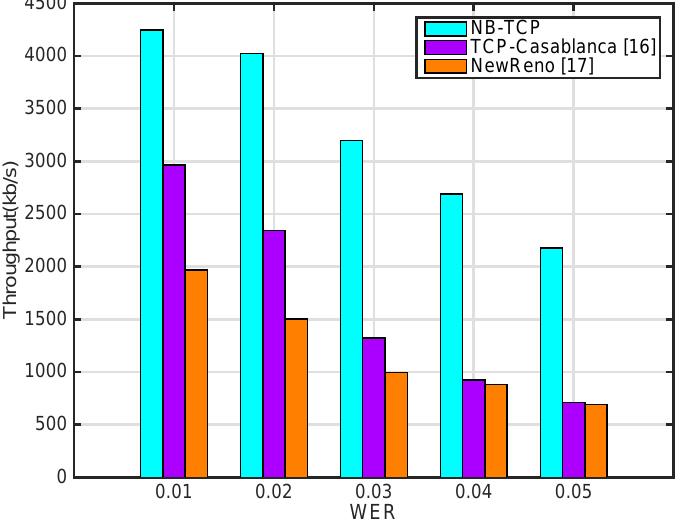
Figure 3. Average throughput versus WER.